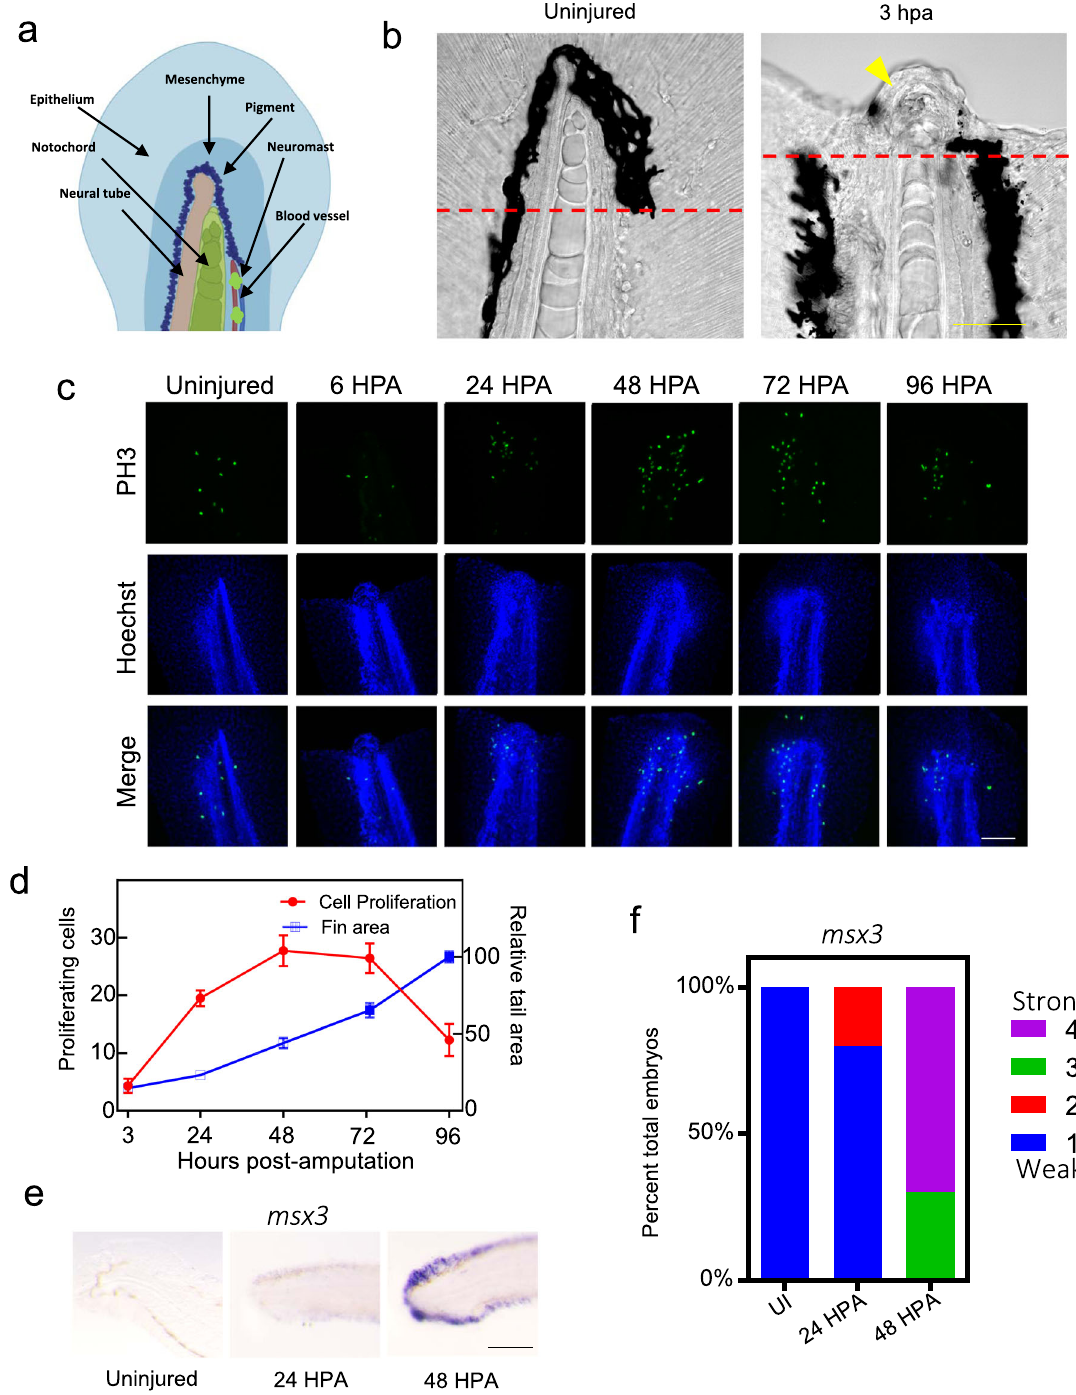
Fig. 1 Tail regeneration following amputation in zebra fi sh embryos. a An illustration showing tissues that are regenerated following tail amputation. b Left, a normal tail fi n with the amputation plane indicated with a dashed red line. Right, an image depicting the notochord bead formation (yellow arrowhead) at 3 HPA. Embryos are 3 DPF. Scale bar = 50 µm. c Tail images of PH3 + following tail amputation at indicated timepoints in hours post-amputation. Uninjured embryos are 4 DPF. Amputations were performed at 3 DPF. Images are sum z-stack projections of 1 µM slices through the entire embryo. Scale bar = 100 µm. d Quanti fi cation of cell proliferation as determined by PH3 + cells and tail area during regeneration. For tail area, N = 10 at all timepoints. For proliferation, N = 10, 10, 8, 9, and 7 for 3, 24, 48, 72, and 96 HPA, respectively. Mean and SEM are shown. e In situ hybridization of the blastema marker msx3 in uninjured animals and at 24 or 48 HPA. Scale bar = 100 µm. f Stacked percentage graph of msx3 expression as determined by in situ hybridization. A score of 1 represents little to no staining, while a score of 4 represents strong staining. N = 10 embryos for all